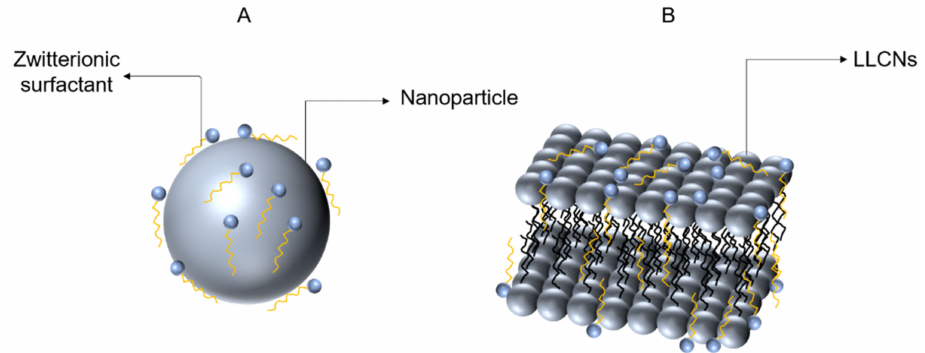
Figure 5. ( A ) The surface coating mode; ( B ) the insertion